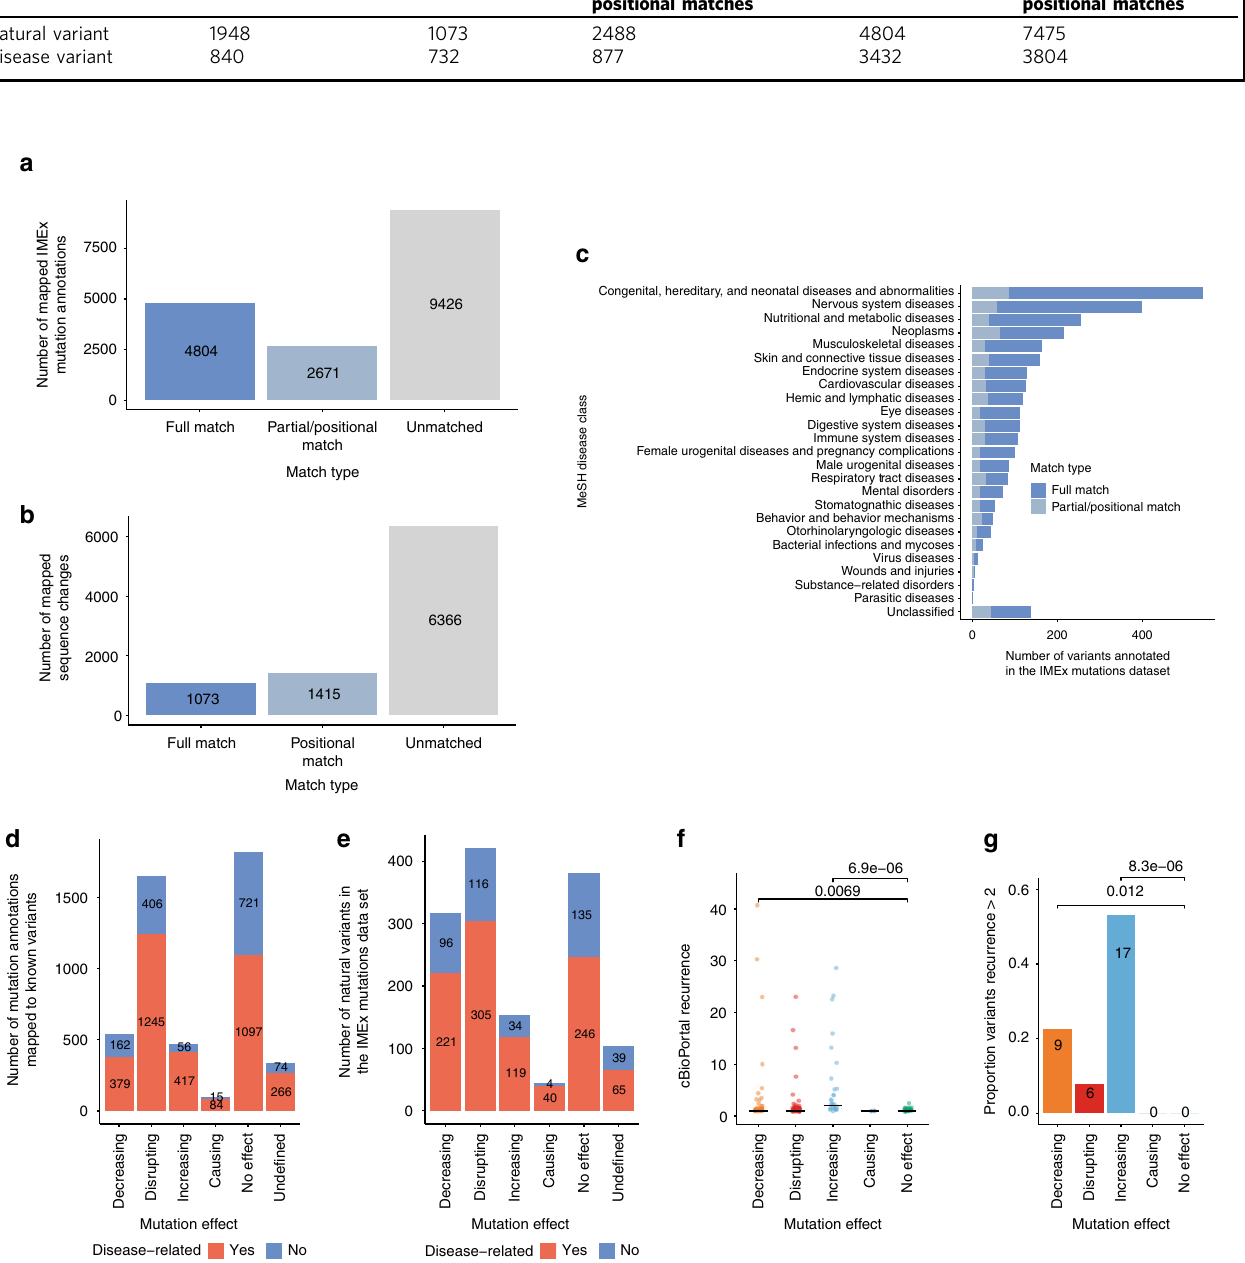
Fig. 3 Genomic variation and disease annotations in the IMEx mutations data set. a Mapping IMEx mutation annotations to UniProtKB human variants; b Mapping UniProtKB human variants to IMEx-reported sequence changes; c Distribution of IMEx mutation annotations associated with selected MeSH disease classes (see Supplementary Data 3 for a complete list of disease-mutation associations). Bars are coloured according to the type of mapping between disease variants and IMEx mutation annotations (full match: blue, partial/positional match: grey); d IMEx mutation annotations by effect type and their relation to disease; e IMEx mutation sequence changes by effect type and their relation to disease; f cBioPortal recurrence scores for mutations grouped by effect type. p -values calculated with one-sided Wilcoxon test are indicated (decreasing vs no effect W = 582.5; increasing vs no effect W = 521.5); g Proportion of highly recurrent cancer variants according to cBioPortal by effect type. p -values calculated with Fisher exact test are indicated. Source data are provided as a Source Data fi